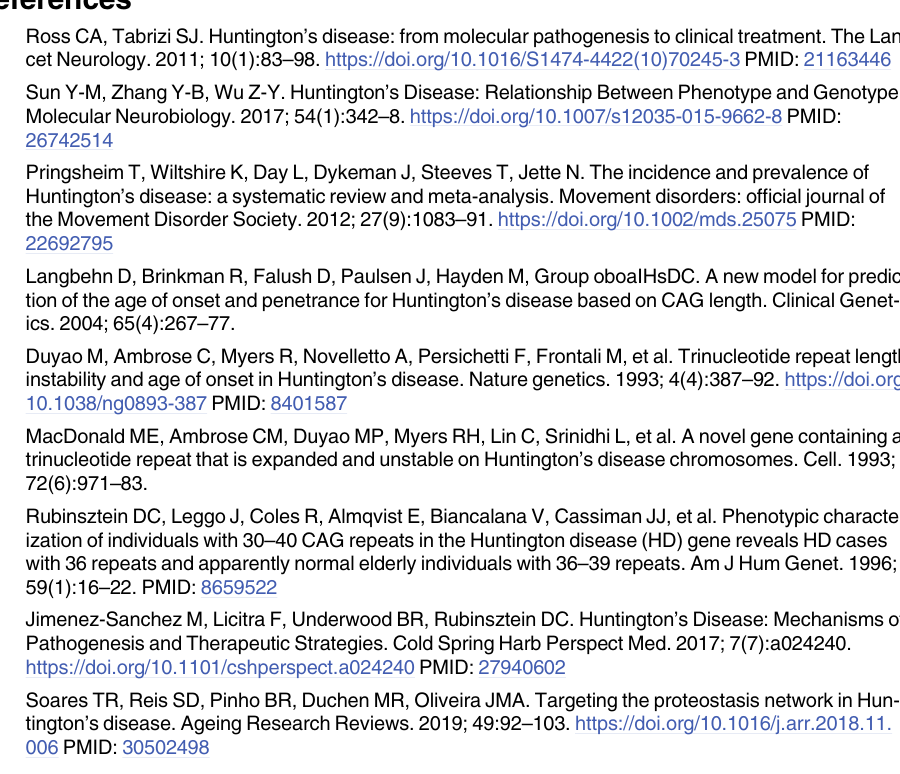
S3 Fig. Different proteasome complex composition in HEK293 and ST Hdh cells. Native PAGE showing different proteasome complexes in HEK293 and STHdh cells. Immunoblots for α 7, RPT1 and PA28 α show core complexes, 19S activated proteasomes and PA28 αβ acti- vated proteasomes,